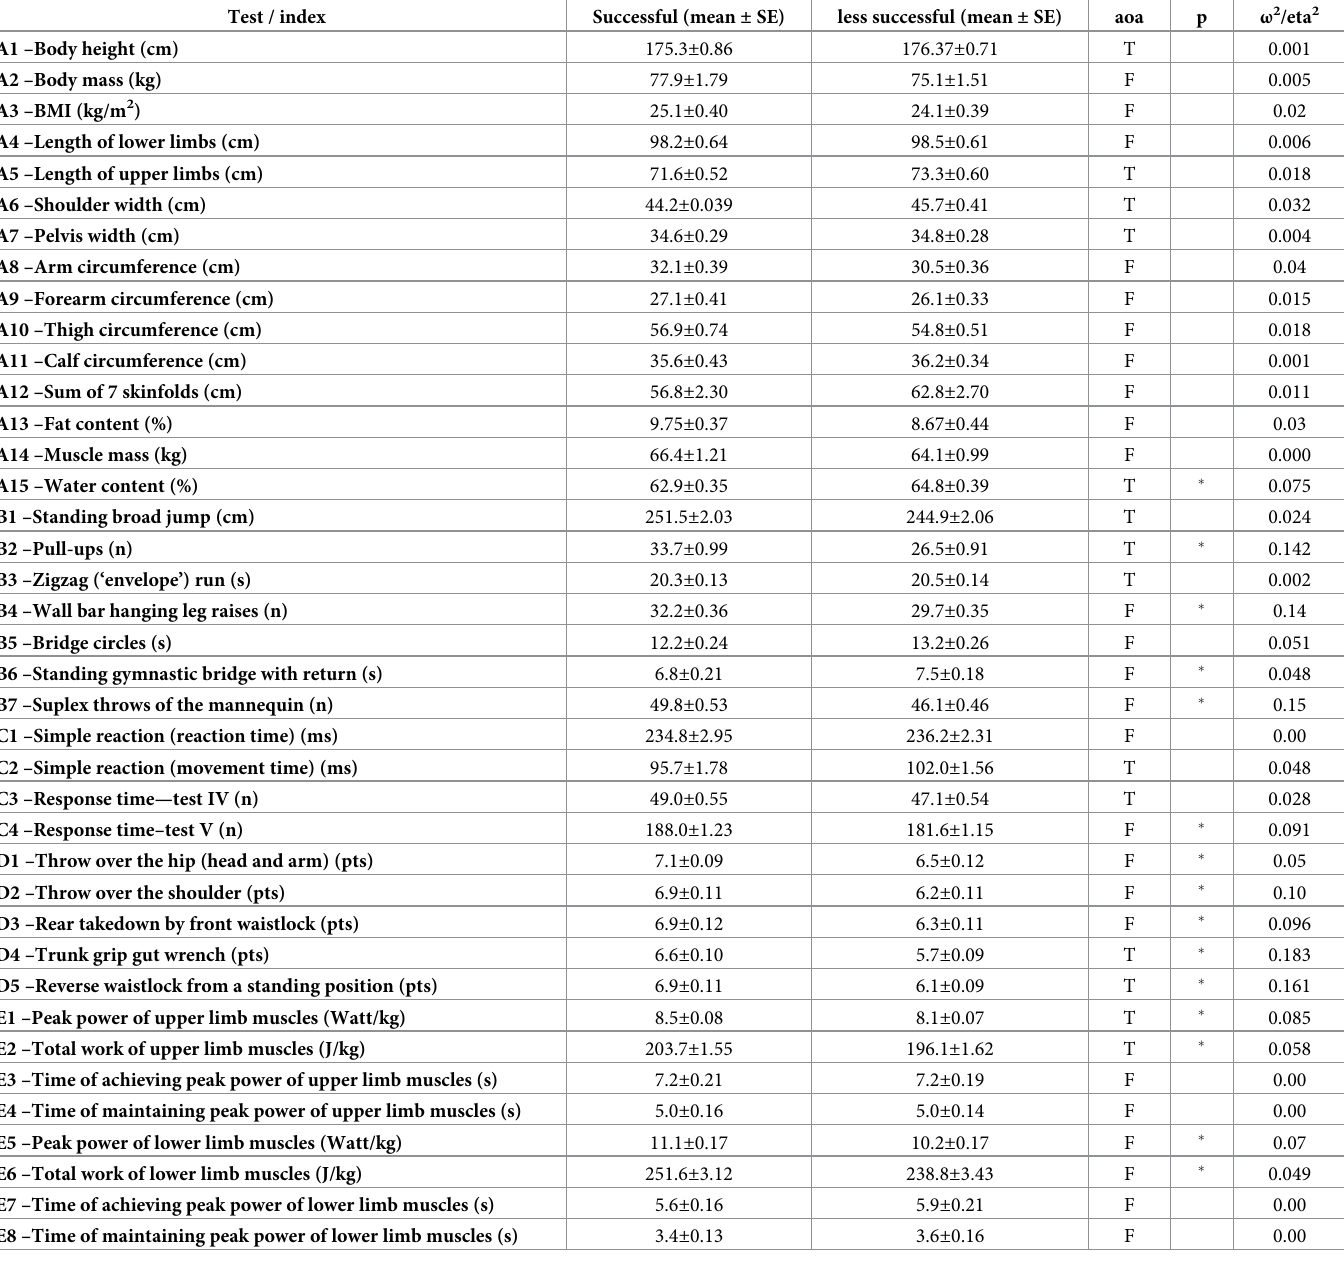
Table 2. Differences between successful and less successful wrestlers in tests performed, groups’ descriptive statistics and effect size. Test /